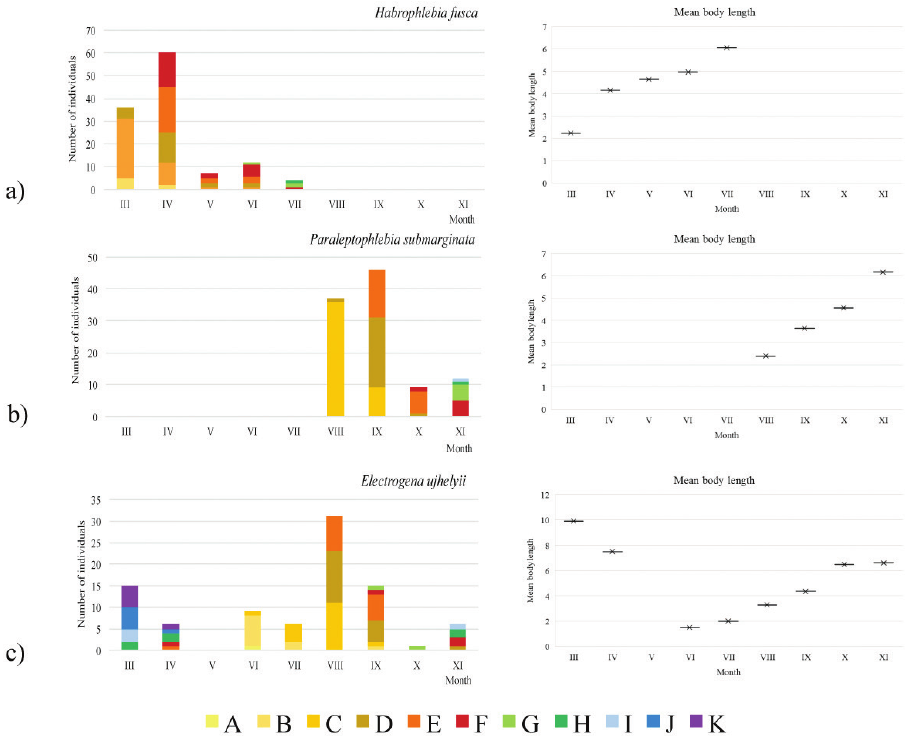
Figure 5. Seasonal dynamics of a Habrophlebia fusca b Paraleptophlebia submarginata c Electrogena ujhelyii in Danković klada Stream between March and November 2015. Legend: Body length category: A = 0.00–0.99 mm; B = 1.00–1.99 mm; C = 2.00–2.99 mm; D = 3.00–3.99 mm; E = 4.00–4.99 mm; F = 5.00–5.99 mm; G = 6.00–6.99 mm; H = 7.00–7.99 mm; I = 8.00–8.99 mm; J = 9.00–9.99 mm; K = 10.00–10.99